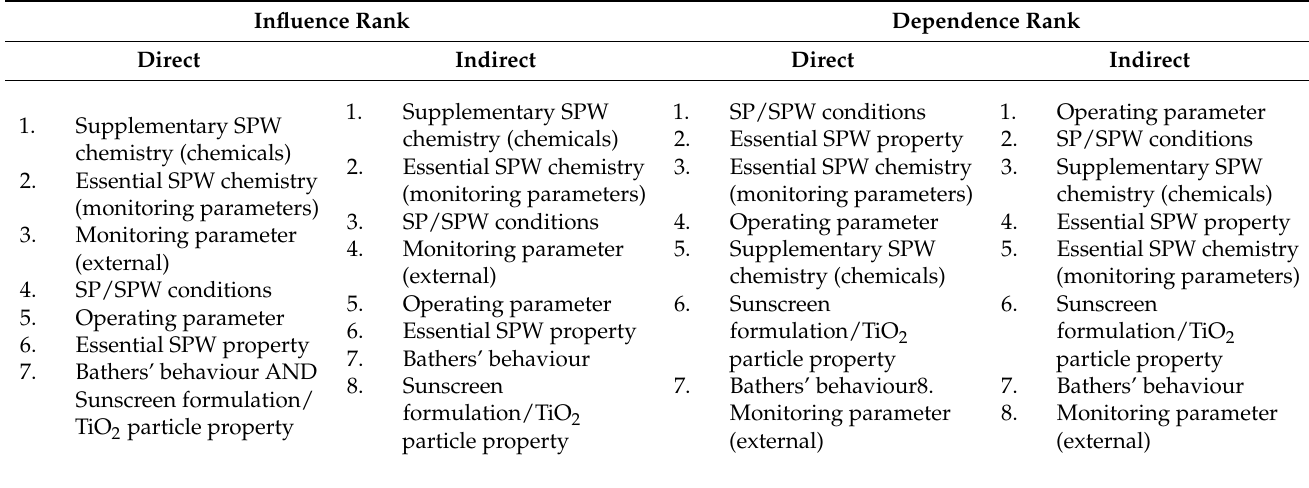
Table 2. Direct and indirect influence and dependency rating of variable groups according to the MICMAC